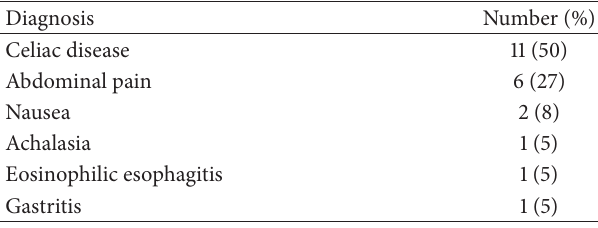
Table 3: Primary cardiac diagnoses of the Fontan patients.